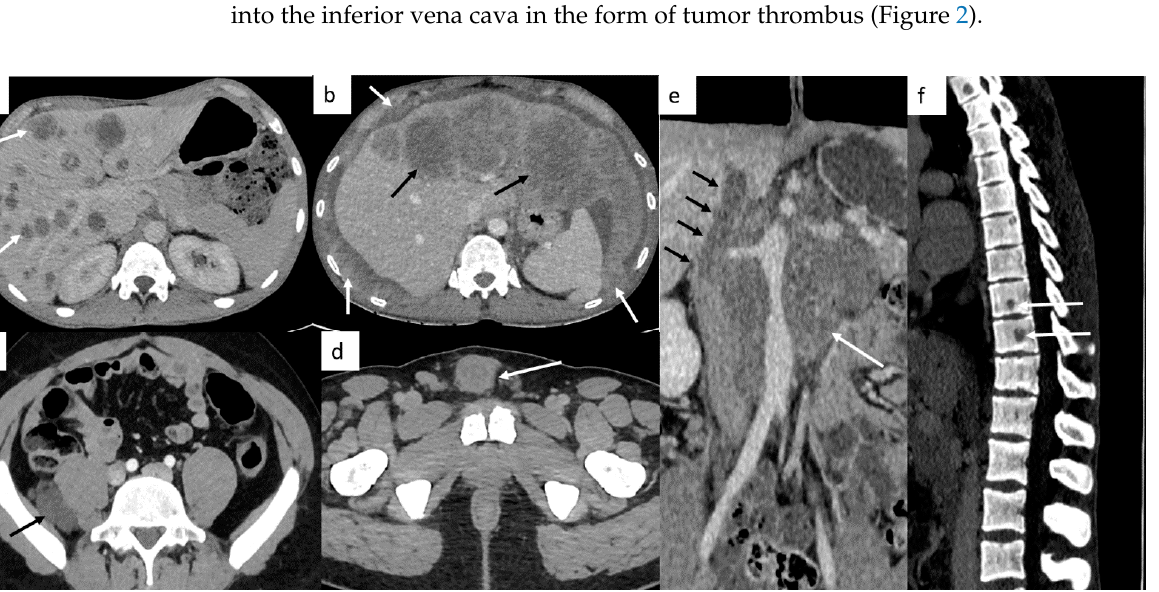
Figure 2. Other sites of metastatic disease. In advanced stages, abdominal CT can show different sites of metastases including liver ( a , b , black arrows), peritoneal carcinomatosis ( b , white arrows), retroperitoneal carcinomatosis ( c ), cutaneous metastases in front of pubis ( d ). In case of large retroperitoneal lymph nodes ( e , white arrows), a tumor thrombus in the inferior vena cava can be found ( e , black arrows). Spinal bone CT shows several vertebral metastases ( f ). Brain imaging is not routinely performed but is indicated in symptomatic patients, in patients with high risk factors such as choriocarcinoma type tumor (likely hemorrhagic